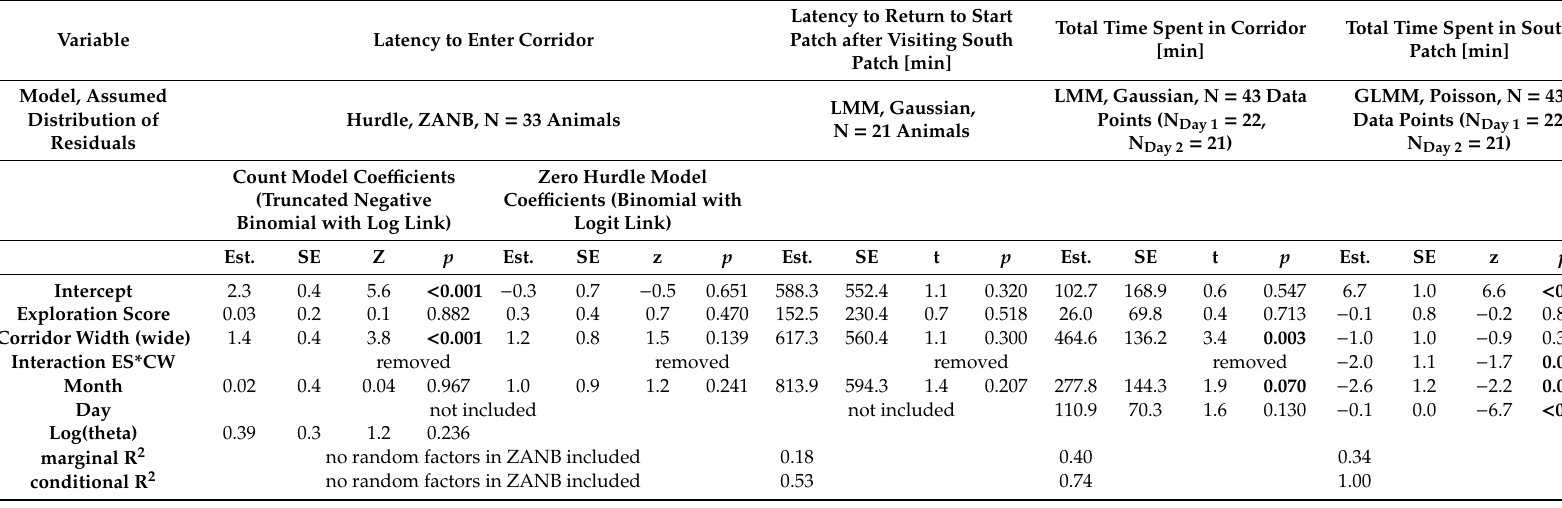
Table 1. Full models of movement observations and main e ff ects. The animal ID and the paired male from the same corridor system were included as random e ff ects. The following models were applied: Zero-altered negative binomial model (ZANB), a two-part model compiled with a hurdle count model; linear mixed e ff ects model (LMM); and generalized linear mixed e ff ects model (GLMM). Additionally, we analyzed the interaction of the exploration score (ES) and the corridor width (CW). Significant results and trends are displayed in bold. The marginal R 2 includes fixed e ff ects and the conditional R 2 includes the full model with fixed and random e ff